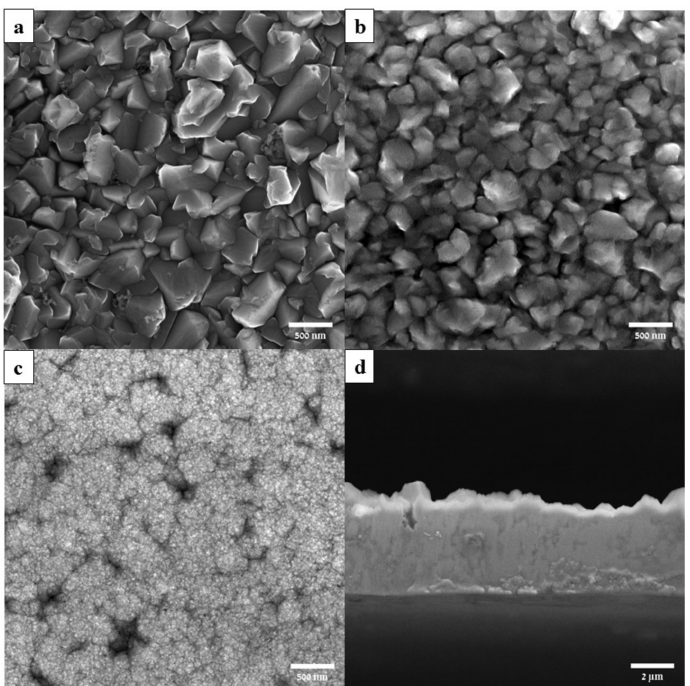
Figure 9. Top view ( a – c ) and cross-section view ( d ) of Al coatings deposited under different potentials: ( a ) sample E52 ( − 1.3 V, 12.6 C/cm 2 ), ( b ) sample E46 − 1.45 V, 2.2 C/cm 2 ), ( c ) sample E40 ( − 1.5 V, 3.0 C/cm 2 ), and ( d ) sample E34 ( − 1.3 V, 120 min, 13.9 C/cm 2 ). See Table 1 for further